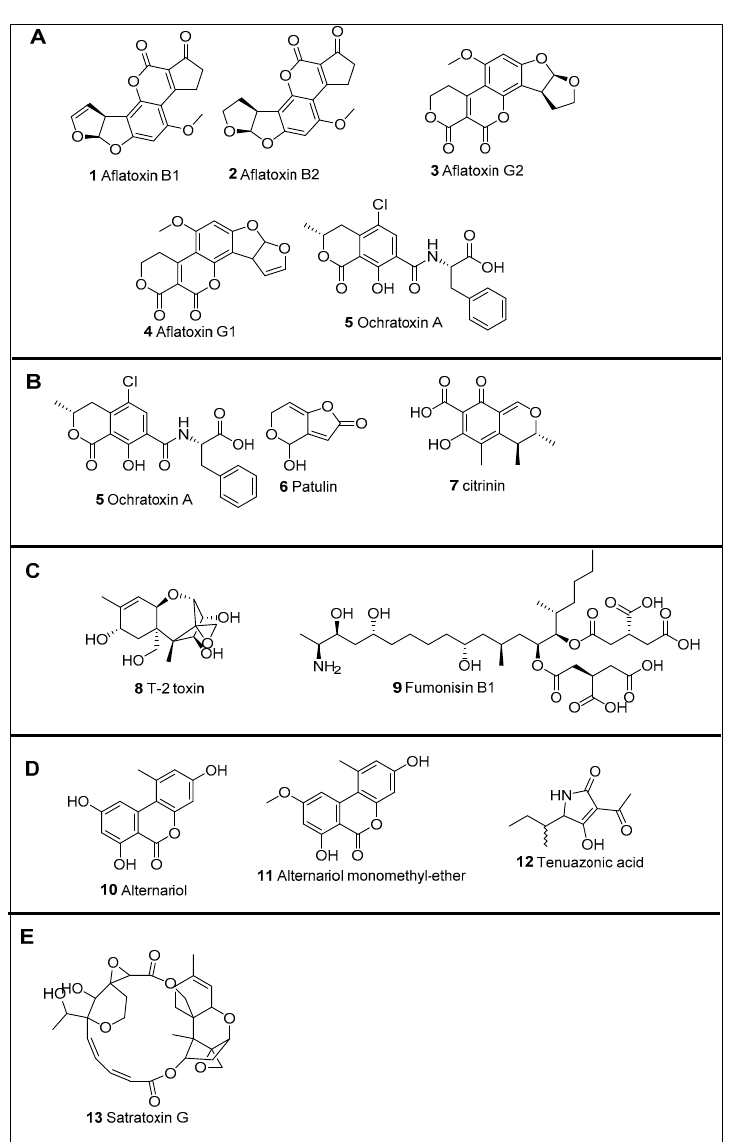
Figure 1. Common mycotoxins—( A ). Aspergillus spp. ( B ). Penicillium spp. ( C ). Fusarium spp. ( D ). Alternaria spp. ( E ). Stachybotrys spp.